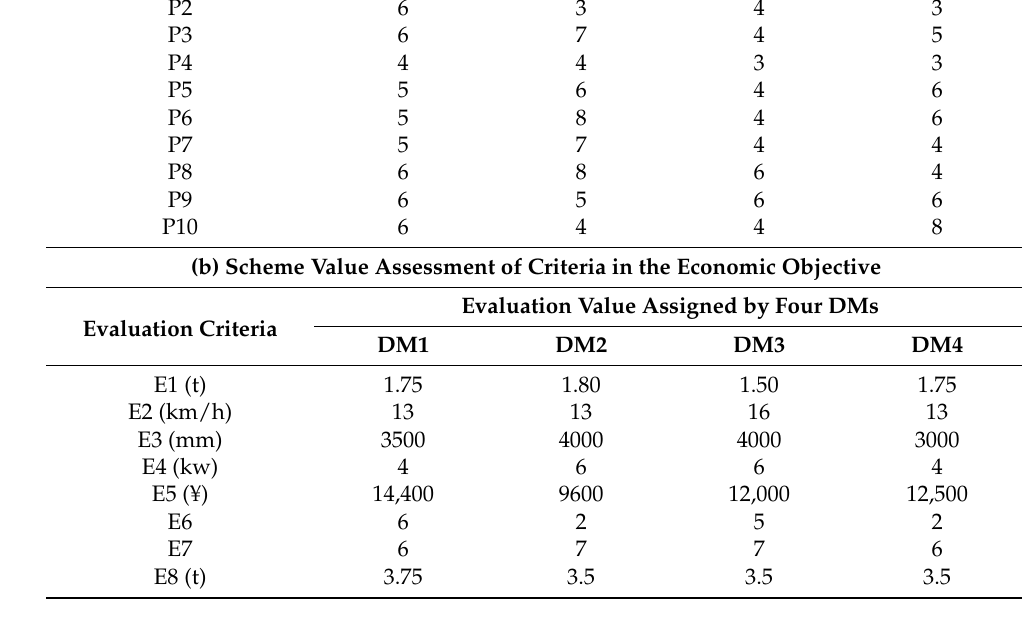
Table 8. Initial evaluation matrix of the electric forklift PSS concept (taking the CS 1 as an example). (a) Scheme Value Assessment of Criteria in the CV Objective Evaluation Criteria